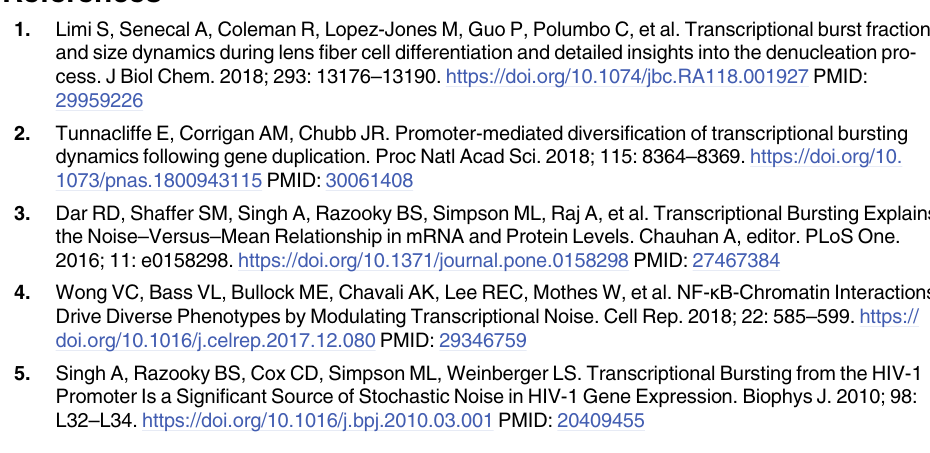
S5 Fig. Model fits of experimental HIV data compare to simulations using computational multi-step activation scheme (related to Fig 6). (A-C) Scatterplots of results from simulation of the three-state transcriptional cycling model without feedback compared to experimental measurements of mRNA distributions from populations of T cells harboring latent HIV inte- grations and stimulated with TNF with Tat feedback blocked (from ref. 4). Correlation between simulation and experimental data is shown for mRNA average (A), Fano factor (B), and CV (C). Error bars represent 95% bootstrapped confidence intervals. S6 Fig. Comparisons of average mRNA and Fano factor across activation paths (related to Fig 7). (A-B) Average mRNA counts (A) and Fano factor (B) for the four activation paths across the four HIV integrations for timepoints of 0, 1, 2, 4 and 24 hours. mRNA counts were generated through stochastic simulation for 1,000 cells for each parameter combination. Error bars represent 95% bootstrapped confidence intervals. (C) Percentage of cells above ‘ON’ threshold (set at 250 proteins per cell) at 24